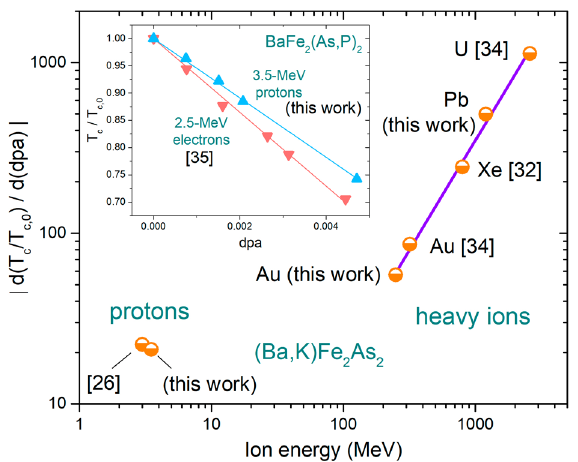
Figure 6. Absolute value of the critical temperature degradation rate, | d ( T c / T c ,0 )/ d ( dpa ) | , of (Ba,K) Fe 2 As 2 crystals as a function of the energy of the ion used for irradiation. H, Au, Xe and U irradiation data were also taken from 26,32–34 . Data for heavy ions are fitted by a linear dependence in the log–log scales, leading to the scaling relation reported below in Table 1. The inset shows a comparison of T c degradation for BaFe 2 (As,P) 2 crystals irradiated with 3.5-MeV protons (this work) and with 2.5-MeV electrons (from 35 ), fitted by a linear